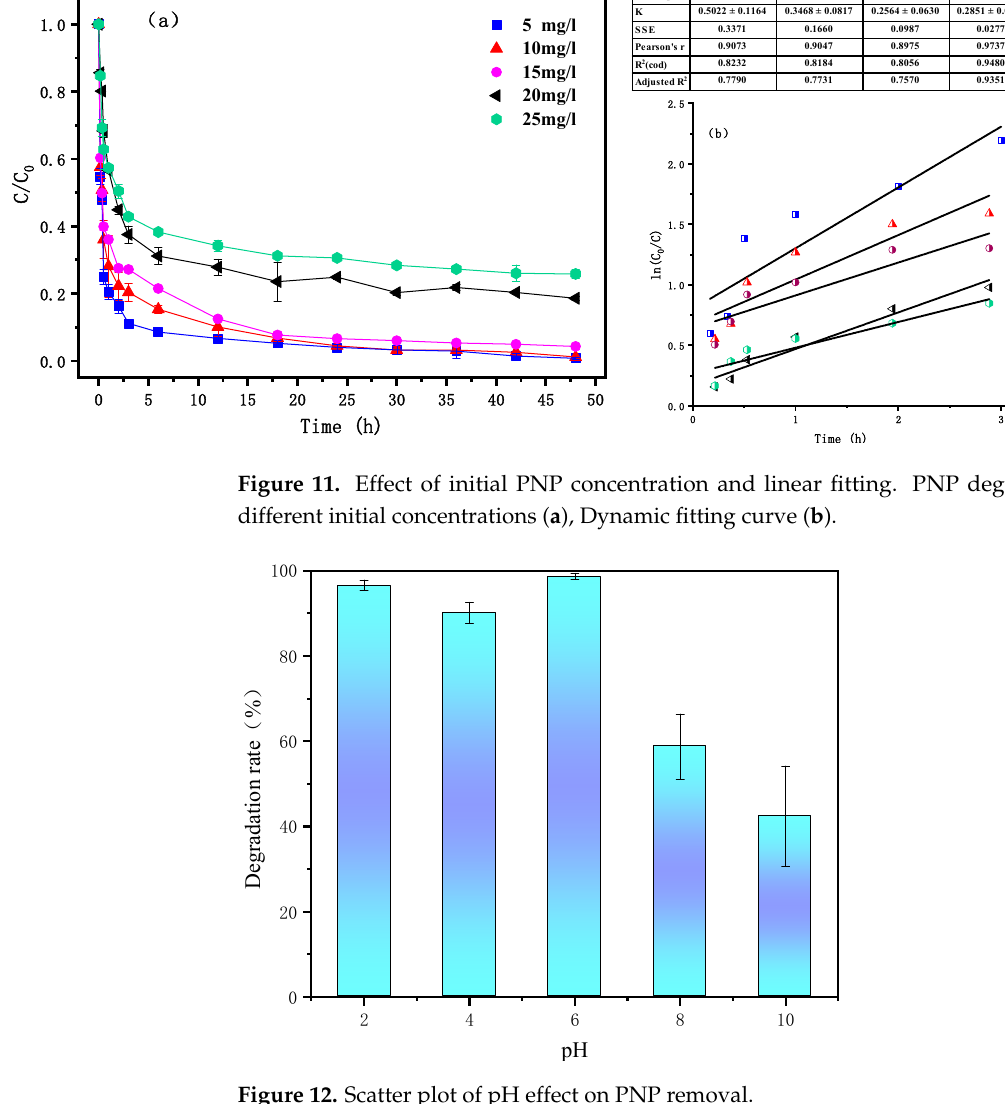
Figure 12. Scatter plot of pH effect on PNP removal.